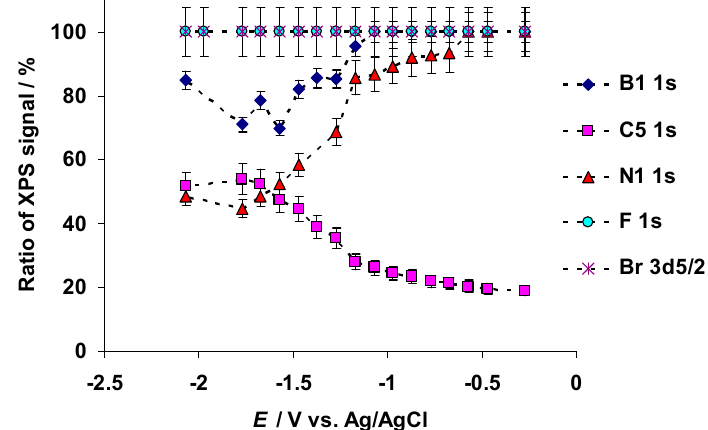
Figure 3. Dependence of EMIm + “aliphatic” carbon C 1s (marked in the figure as C5), imidazolium nitrogen atoms N 1s (N1), BF 4 − anion boron B 1s (B1), BF 4 − anion fluorine F 1s, and Br − anion bromine Br 3d 5/2 photoelectron peaks ratios for the 5 wt % EMImBr solution in EMImBF 4 at various C(Mo 2 C) electrode negative potentials. No changes in the shapes of the F 1s (Figures 2d and 3) and Br 3d (Figures 2e and 3) XPS signals were noted, indicating high electrochemical stability of these elements within the negative electrode potential range. The decrease in intensities of the B 1s, F 1s, and Br 3d XPS signals, notable in Figure 2c–e, could be explained by the decrease in the concentration of Br - and BF 4- anions at the ionic liquid–carbon surface due to electrostatic repulsion of anions from the negatively charged C(Mo 2 C) electrode. Analysis of the relationship between the C 5 1s, N1 1s, B1 1s, F 1s, and Br 3d 5/2 PE BEs upon the potential applied to micro-mesoporous C(Mo 2 C) electrode indicated that d BE d E − 1 = − 1 eV V − 1 for C 5 1s, N1 1s, B1 1s, F 1s, and Br 3d 5/2 within the potential range from − 1.17 to 1.23 V (the d BE d E − 1 slope values are presented in Table S2, given in the supplementary information). However, for the potential range from − 2.07 to − 1.17 V, d BE d E − 1 = − 0.5 eV V − 1 for C 5 1s, N1 1s, B1 1s, F 1s, and Br 3d 5/2 PEs. Therefore, the twofold decrease in the d BE d E − 1 slope, the formation of the gas bubbles at the C(Mo 2 C) electrode and the new shoulder into the initial B 1s PE peak, and the formation of a B–O bond at E = − 1.17 V were initiated by reduction processes at the electrode surface. 3.2. The Electrochemical Measurements Data at Negatively Polarized C(Mo 2 C) Electrode The cyclic voltammetry (CV) curves for the negatively polarized micro-mesoporous C(Mo 2 C) electrode soaked in the 5 wt % EMImBr solution in EMImBF 4 at various fixed potential sweep regions are shown in Figure 4. Intensive electroreduction of the imidazolium cation [13,40,46,47] started at E = − 1.90 V, parallel to the remarkable increase in the pressure in the XPS measurement chamber (Figure 5a). (The behavior of the XPS chamber pressure at the positive C(Mo 2 C) electrode potentials is explained later in the text.) In Figure 5b, the XPS vacuum chamber pressure values, containing also our previously published data [40,46,47], show that intensive electroreduction